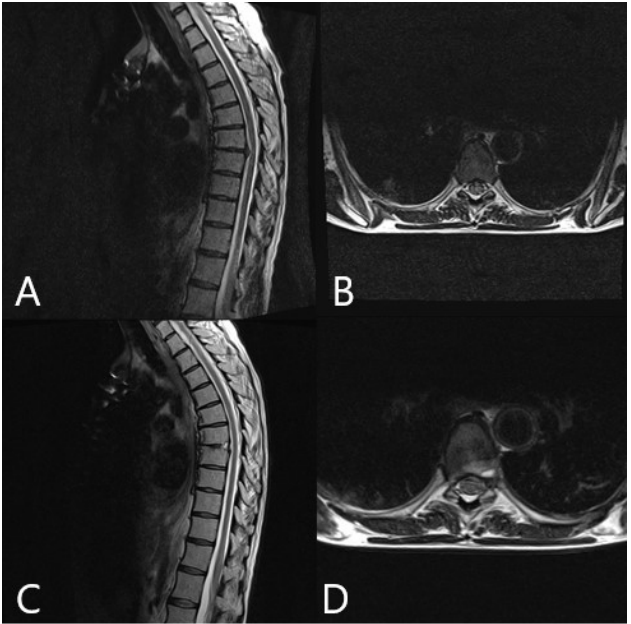
Figure 4. Same patient as in Figures 2 and 3. (patient no. 10), surgery via a left transpleural approach. MRI of the thoracic spine. ( A ) Preoperative T2 sagittal. ( B ) Preoperative T2 axial. ( C ) Postoperative T2 sagittal, which shows complete resection of the herniated disc. ( D ) Postoperative T2